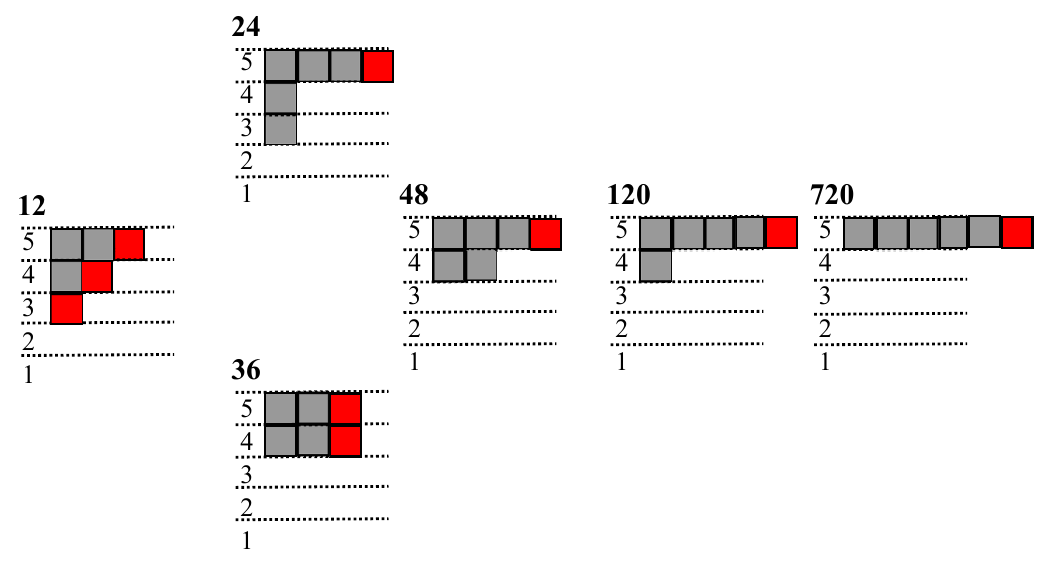
Figure 8 . The tableaux of the non-zero a ’s for the prepared form in five point